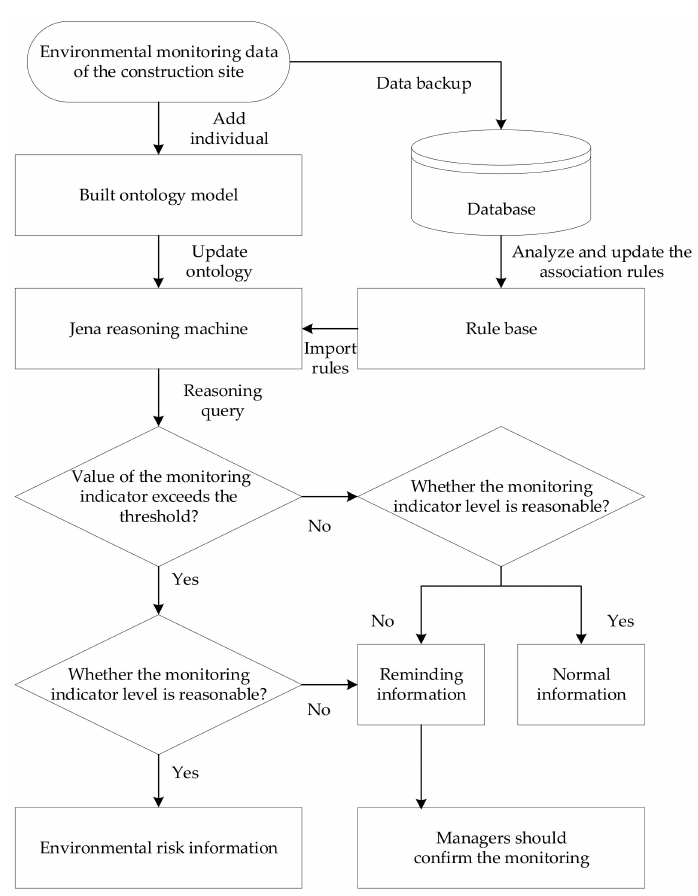
Figure 5. Design ideas of identification